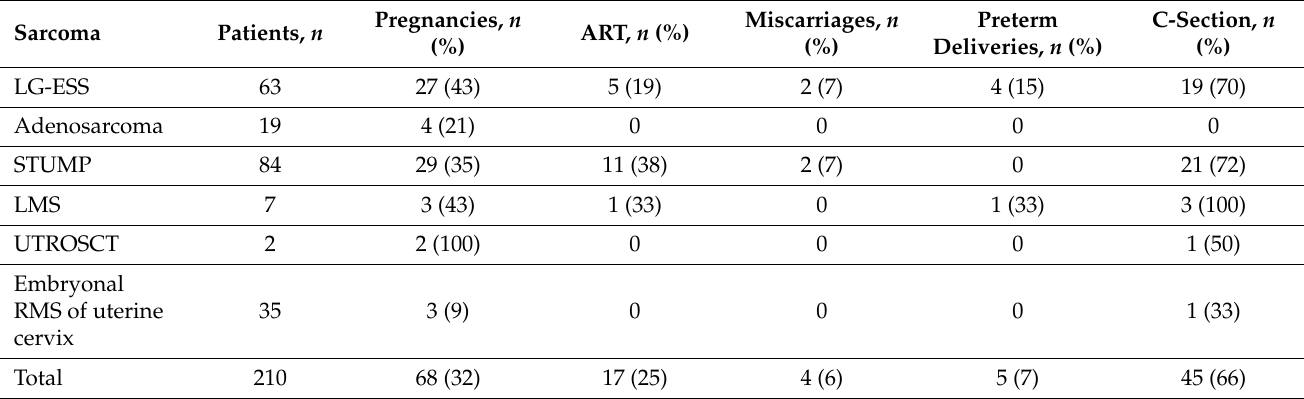
Table 8. Reproductive outcomes after FST of uterine sarcomas.